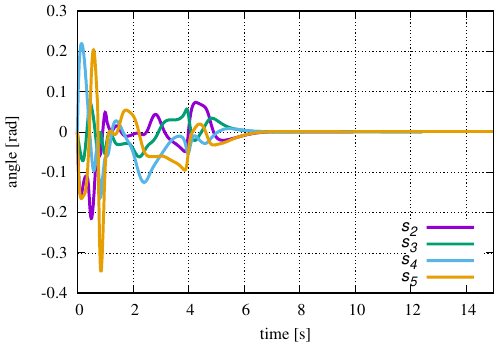
Figure 31. Case 3: Time variation of the twist angle of the springs.